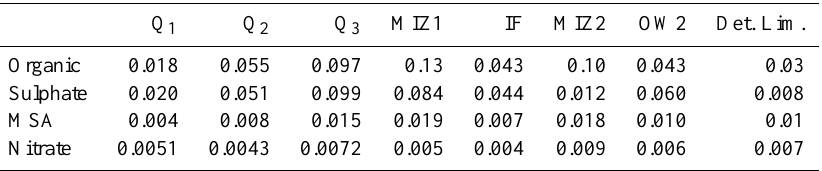
Table 1. 1st, 2nd and 3rd quartiles of AMS measurements, median concentrations for the four stations (see text) and detection limits. All units in µgm − 3 .